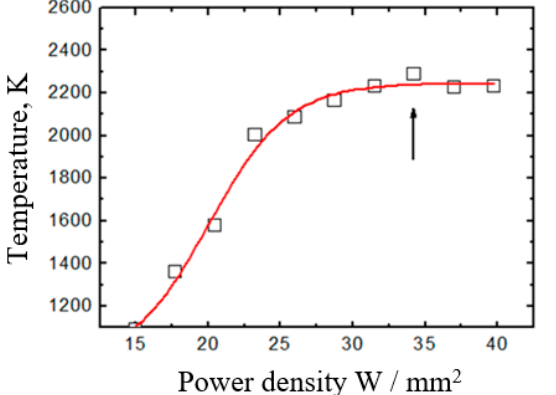
Figure 29. Temperature dependence of the boron target on the electron-beam power density: I b = 80 mA; D b = 5 mm; p = 7 Pa [138]. Temperature saturates due to intensive evaporation after reaching the melting temperature (~ 2300 K).